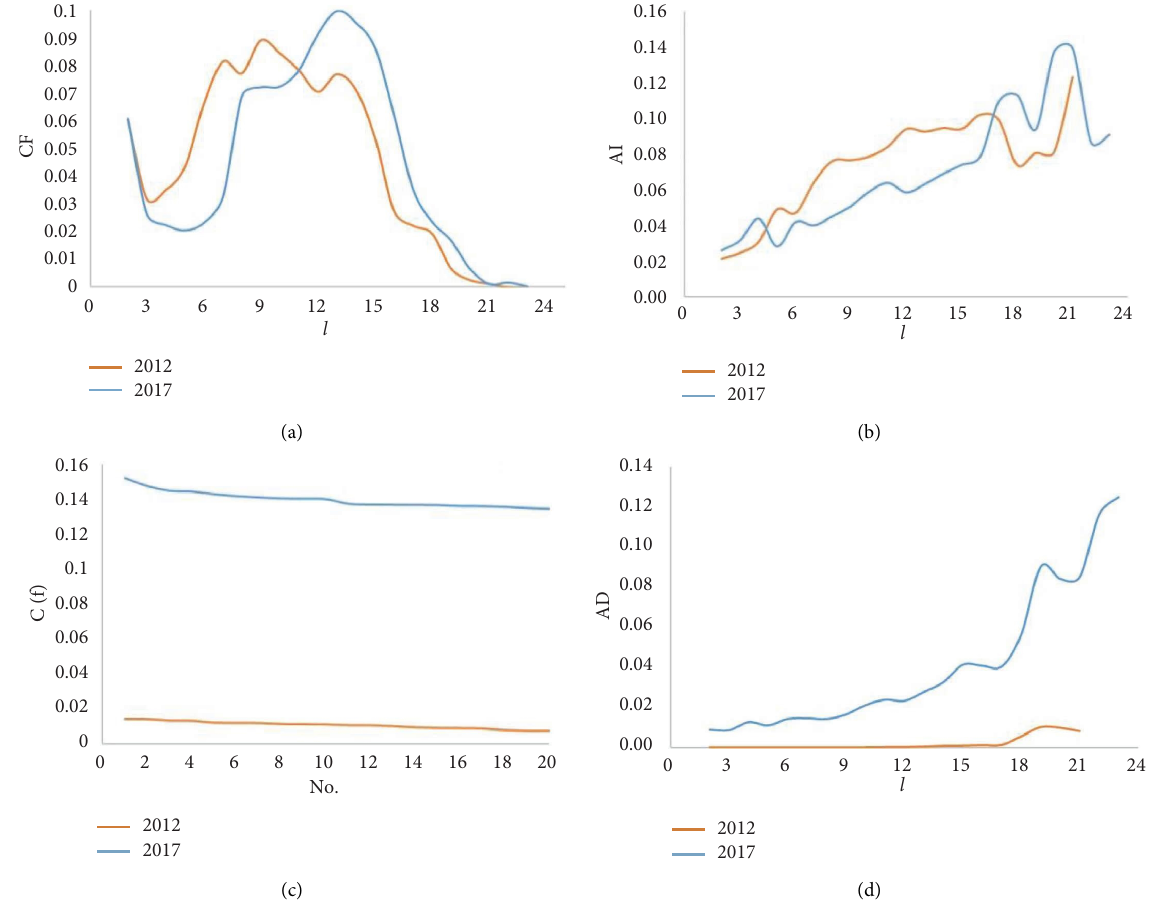
Figure 3: Te cycle circulation efect in 2012 and 2017. (a) Cycle length and relative frequency (CF), (b) average relative investment (AI), (c) cycle centrality (C(f)), and (d) average cycle centrality